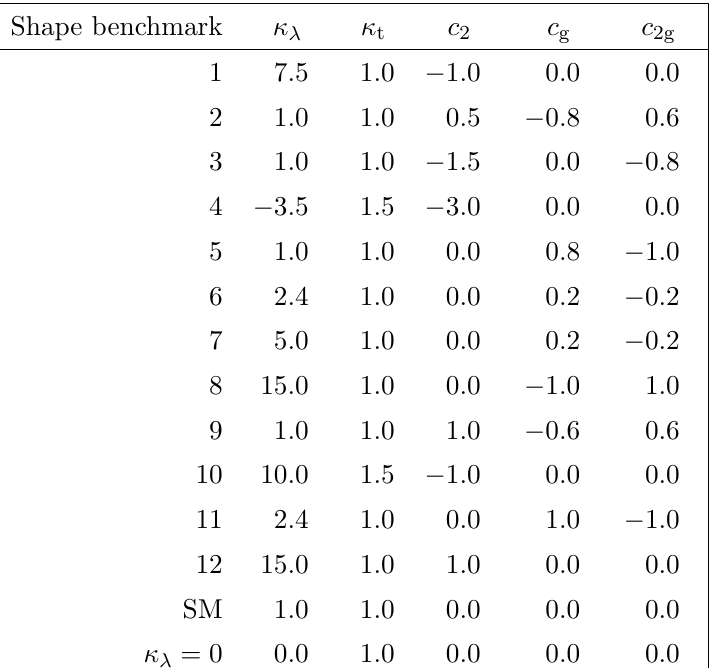
Table 1 . Parameter values of the couplings corresponding to the twelve shape benchmarks, the SM prediction, and the case with vanishing Higgs boson self-interaction, (cid:20) (cid:21) = 0.